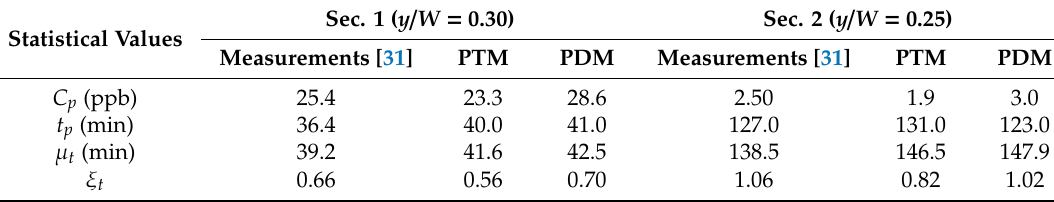
Table 5. Statistical properties of concentration curves in the Hongcheon River.